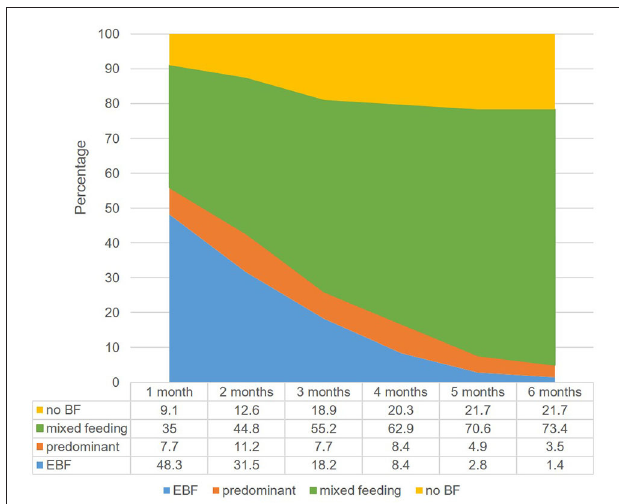
FIGURE 2 | Breastfeeding practice trends. Numbers in the figure’s table represent percentages.